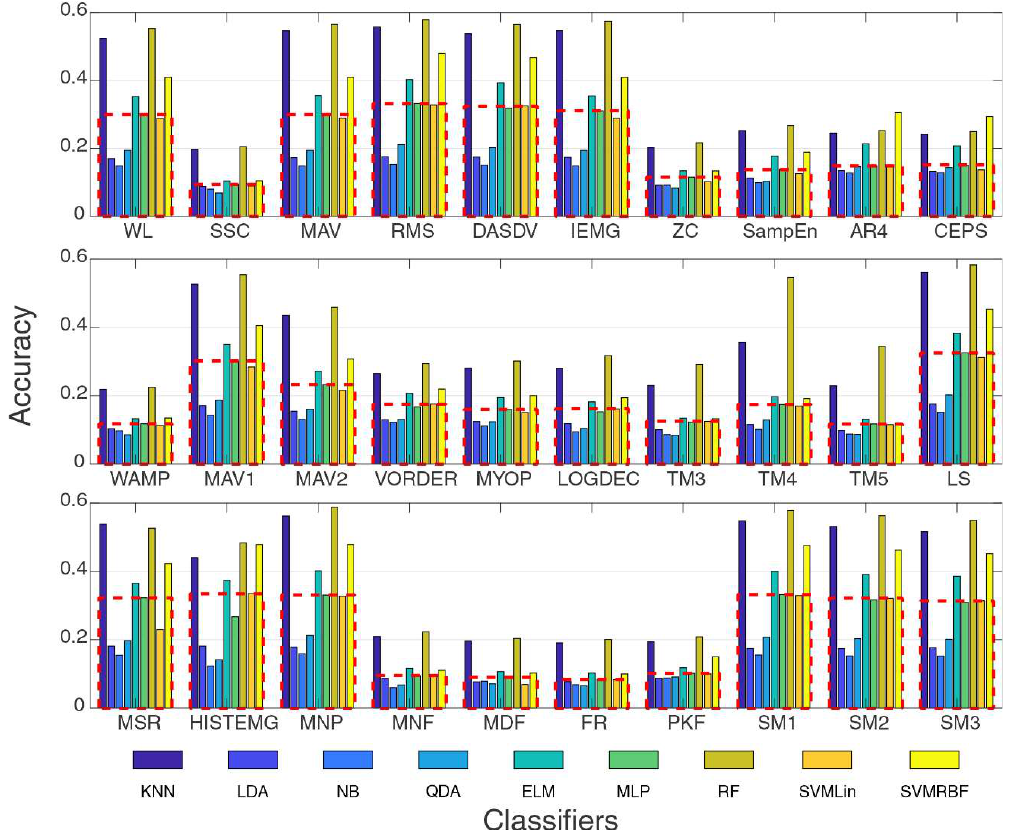
Figure 5. Accuracies for each extracted feature for all the classifiers considered in this work. Their abbreviations are listed in Table 1 and in Abbreviations section. As segmentation parameters, a window of 1 s and an overlap fraction of 1 (100%, a disruptive window without overlapping) were considered. The mean for each feature is presented by the dashed lines. The features with high accuracies were used for the creation of the feature sets G6 to G9.